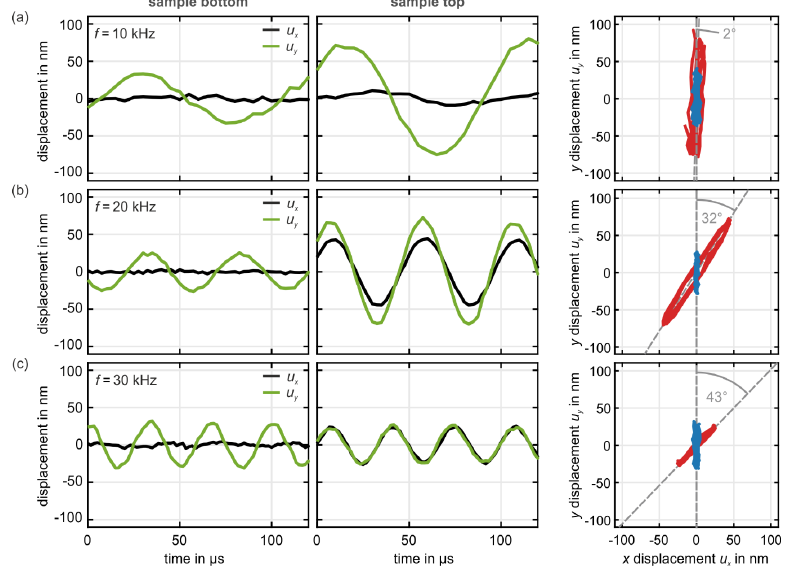
Figure 5. Measured displacement-vector components (black and green) versus time, taken at the sample bottom (left column) and at the top of the sample (middle column), respectively for three different frequencies f. The right column shows the 𝑦 -component versus the 𝑥 -component for the bottom (blue) as well as for the top (red). The sample is excited at its bottom by a piezoelectric transducer with ( a ) 𝑓 = 10 kHz , ( b ) 𝑓 = 20 kHz , and ( c ) 𝑓 = 30 kHz . The metamaterial beam has a cross section of 𝑁 𝑥 × 𝑁 𝑦 = 3 × 3 unit cells and a height of 𝑁 𝑧 = 12 unit cells. From these example data, we derive a polarization rotation angle of ( a ) 𝜑 = 2° , ( b ) 𝜑 = 32° , and ( c ) 𝜑 = 43° . The right column shows the same data represented as 𝑦 -component versus 𝑥 -component for the sample bottom (blue) and the sample top (red). The extracted rotation angles 𝜑 are indicated, too.